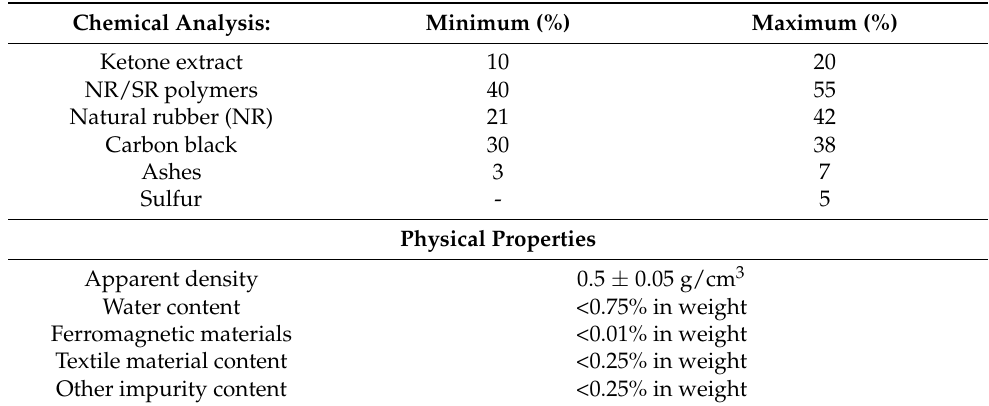
Table 2. Physical properties and chemical analysis of the powdered rubber waste.